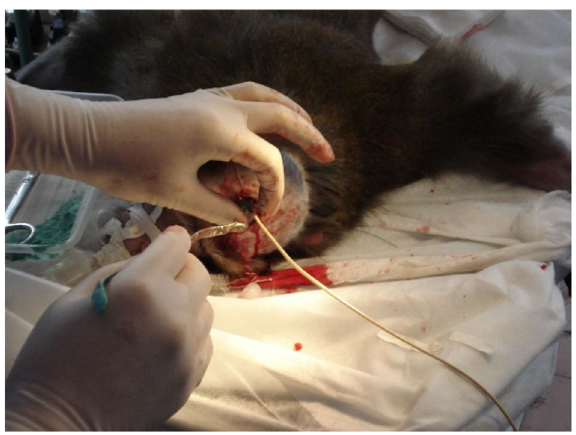
Figure 4. Drilling of the right frontal lobe and insertion of the brain temperature